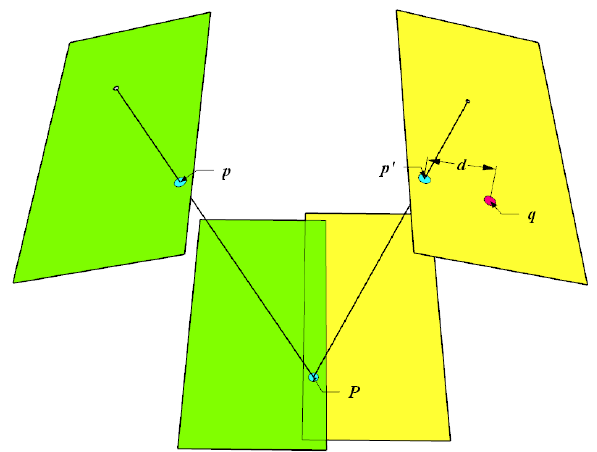
Figure 2. Robust image matching in the low overlap region. Visibility is defined by back-projecting the point 𝒑 from the one image to the object space 𝑷 and then project to the second image 𝒑 ′ . Only mutually visible features (with a buffer distance of 𝑑 ) are considered for pairwise descriptor comparisons. Because RANSAC is not robust when the overlapping area is thin and narrow, the distance threshold 𝑑 is also responsible to test if a match (𝒑, 𝒒) is